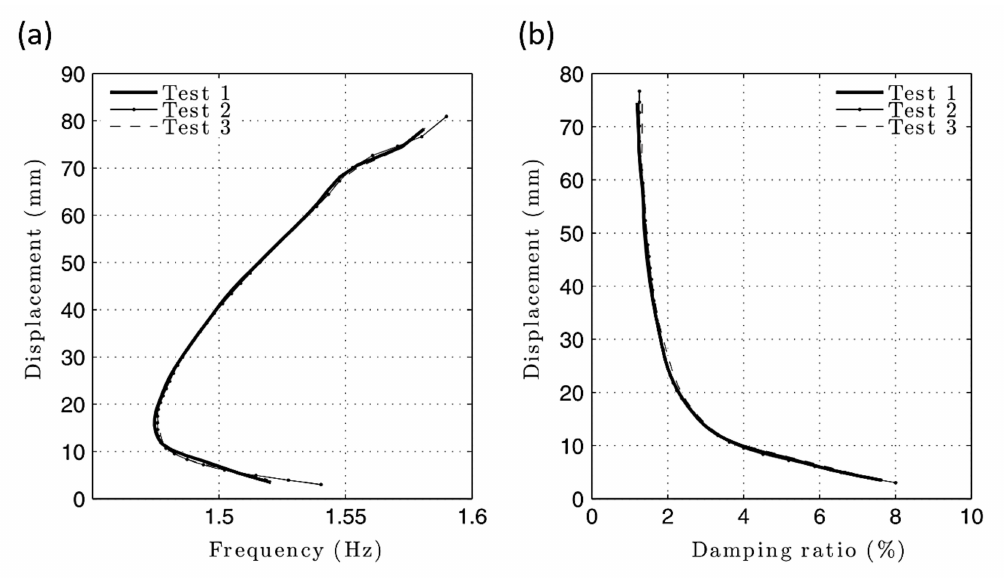
Figure 13. The estimated skeleton curves from the experiment: ( a ) Frequency (Hz); ( b ) damping ratio (%)